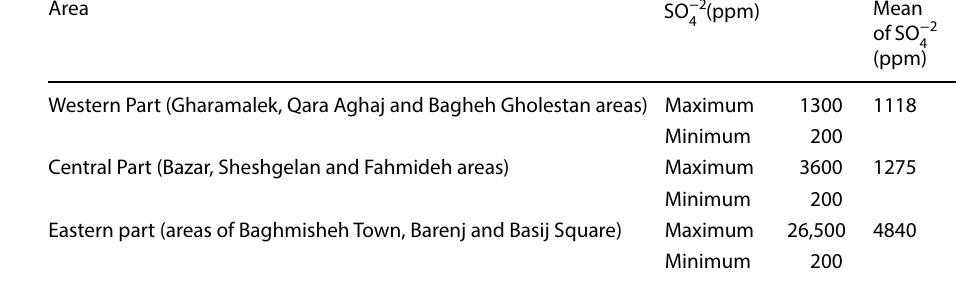
Table 5 Summary of the amount of soluble sulfate in the soil in the route of Tabriz Metro Line 2 (Authors)